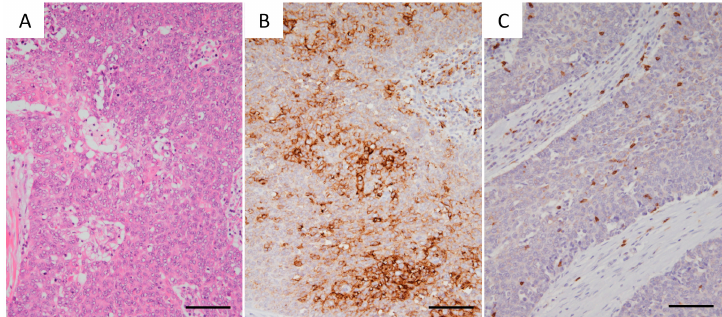
Figure 3. Histological and immunohistological findings for thymic carcinoma. A representative case (Case 38 in Table 1) is shown. ( A ) Hematoxylin and eosin staining. ( B ) PD-L1 Immunohistochemical staining. ( C ) CD8 immunohistochemical staining. Original magnification, 100 × ; scale bar, 100 µ m. A multivariate analysis (to identify factors that a ff ect PD-L1 expression) revealed that only WHO classification was a significant determining factor of PD-L1 expression among